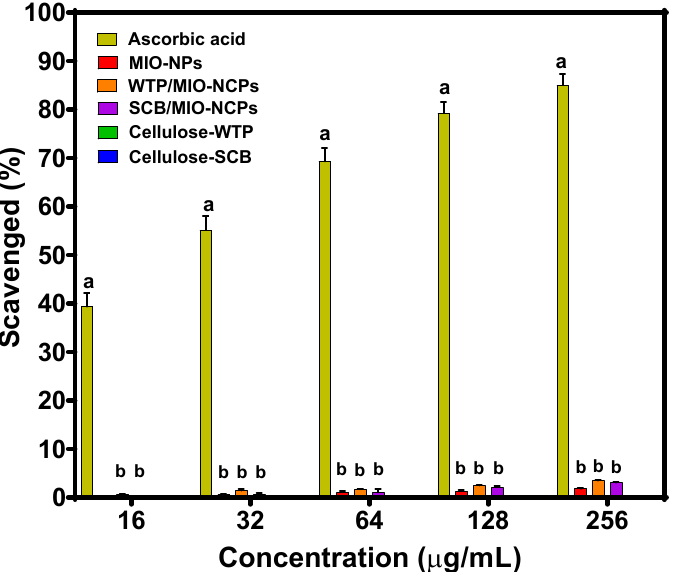
Figure 10. DPPH scavenging assay of ascorbic acid (control), MIO-NPs, WTP/MIO-NCPs, SCB/MIO-NCPs, cellulose-WTP, and cellulose-SCB. Similar letters above bars indicate no significant differences at p -value ≤ 0.05.